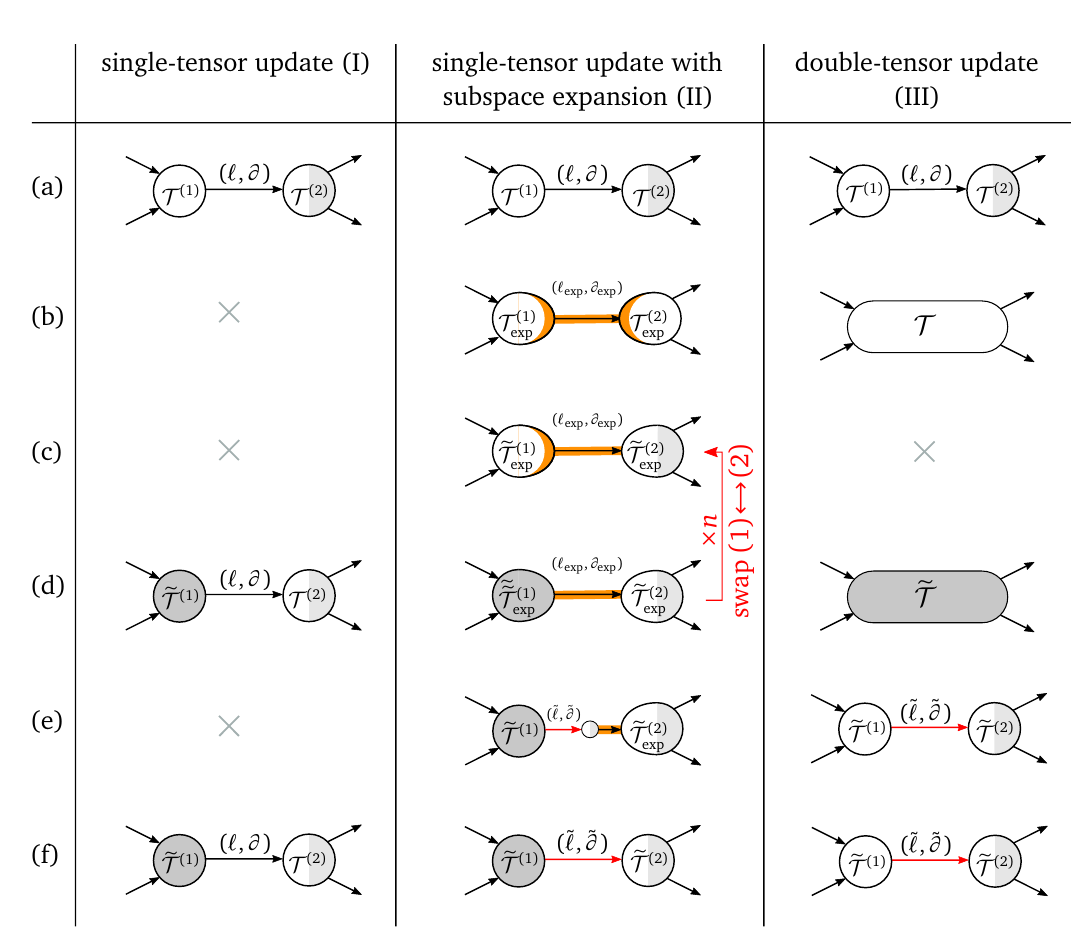
Figure 46: Comparison of different update schemes. (a) Initial configuration (identical in all three schemes). Note that scheme I only operates on one tensor, which means T ( 2 ) is left unchanged throughout this scheme. (b) Making the link representation of the intermediate link variational: scheme I does not have this step; scheme II realizes it via link expansion (see text), while scheme III achieves it via contraction with T ( 2 ) . (c) Restore gauge and compute effective Hamiltonian for T ( 1 ) (only scheme II). (d) Update center node with lowest eigenvector of H . Only scheme II: repeat (c) and eff (d) until converged, the center node being alternately T ( 1 ) and T ( 2 ) . (e) Restoring the original bond dimension of the intermediate link: scheme I does not have this step; scheme II and III realize it via an SVD, discarding the smallest singular values. (f) Final configuration. Note that in scheme II and III the link representation of the intermediate link may have changed, while in scheme I it is